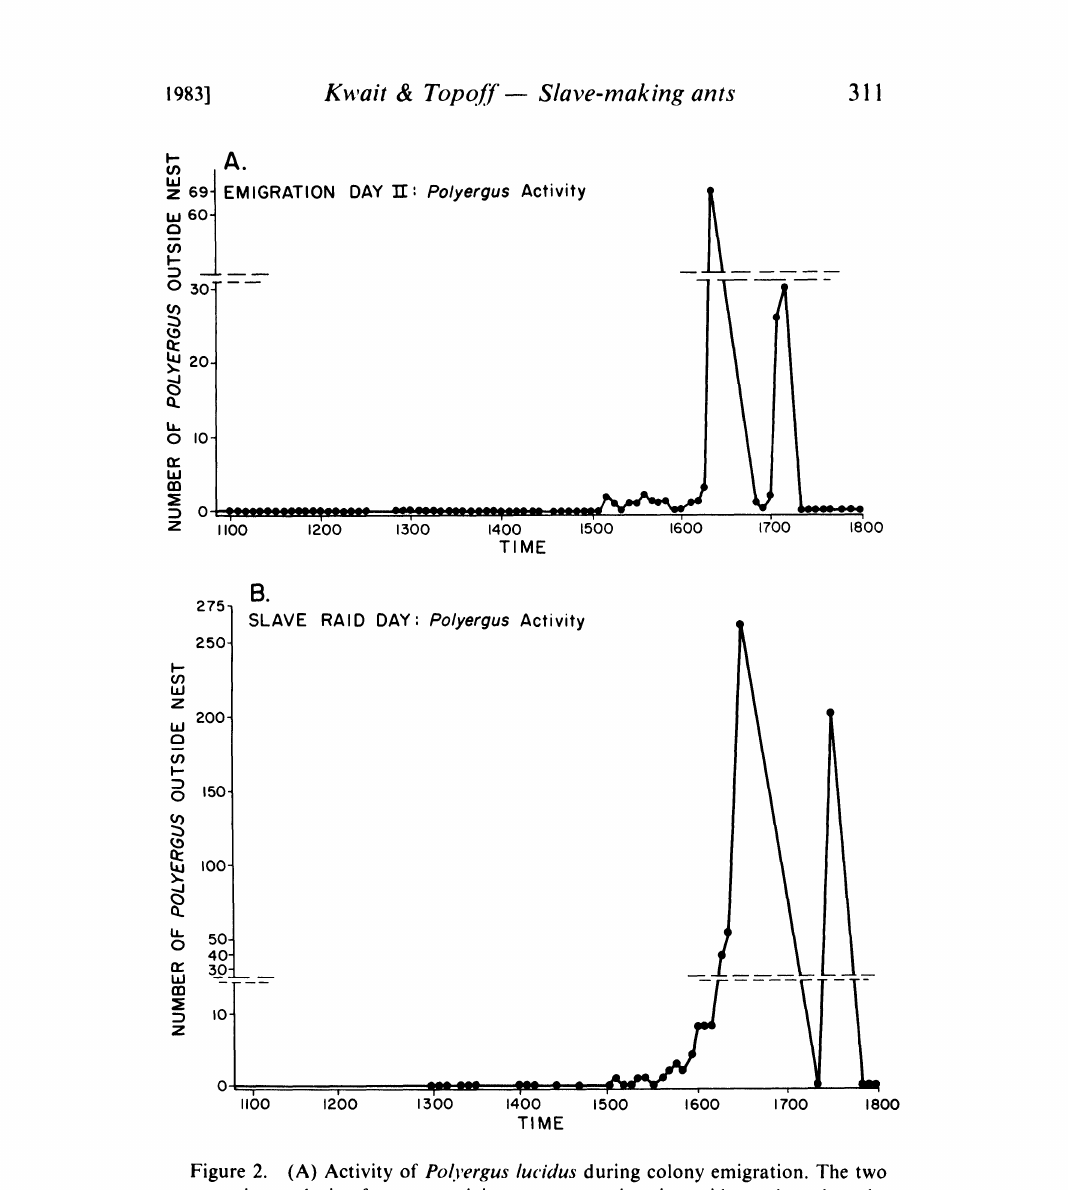
Figure 2. (A) Activity of Polyergus lucidus during colony emigration. The two consecutive peaks in afternoon activity represent emigration raids conducted on the old nest by Polyergus workers that were transported to the new nest by Formica individuals. (B) Activity of P. lucidus during typical slave-raid day. Note the sim- ilarity in timing of slave raids and emigration